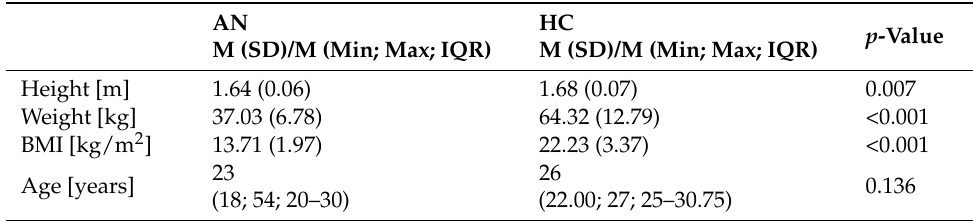
Table 1. Anthropometric data; AN = anorexia nervosa, HC = healthy controls, M = mean, SD = stan- dard deviation, Min = minimum, Max = maximum, IQR = interquartile